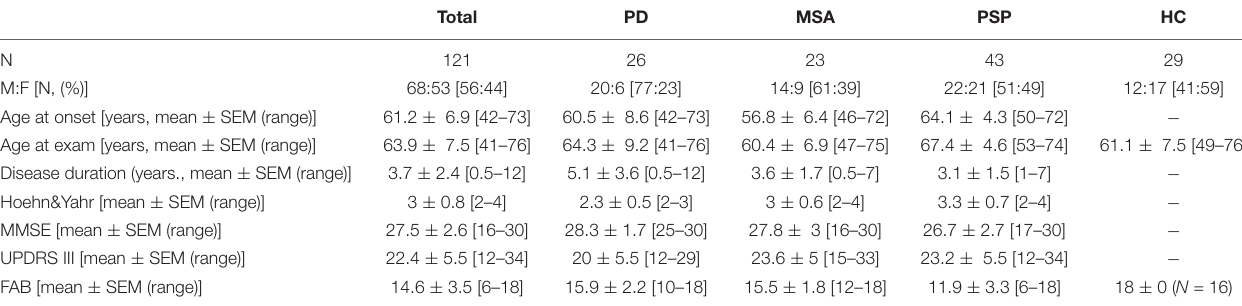
TABLE 1 | Demographic and clinical data of the sample.